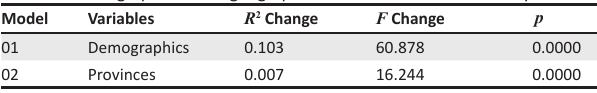
TABLE 5: Demographic versus geographic variation in financial literacy.